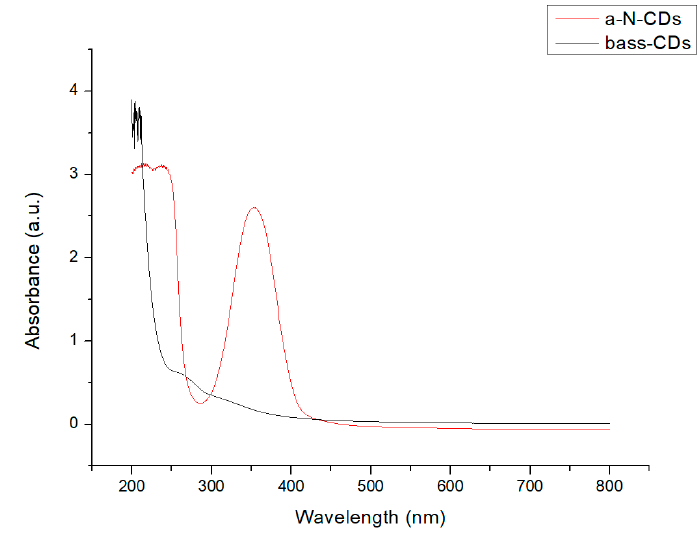
Figure 3. Comparison between UV–Vis spectra of bass-CDs (black line) and a-N-CDs (red-line).